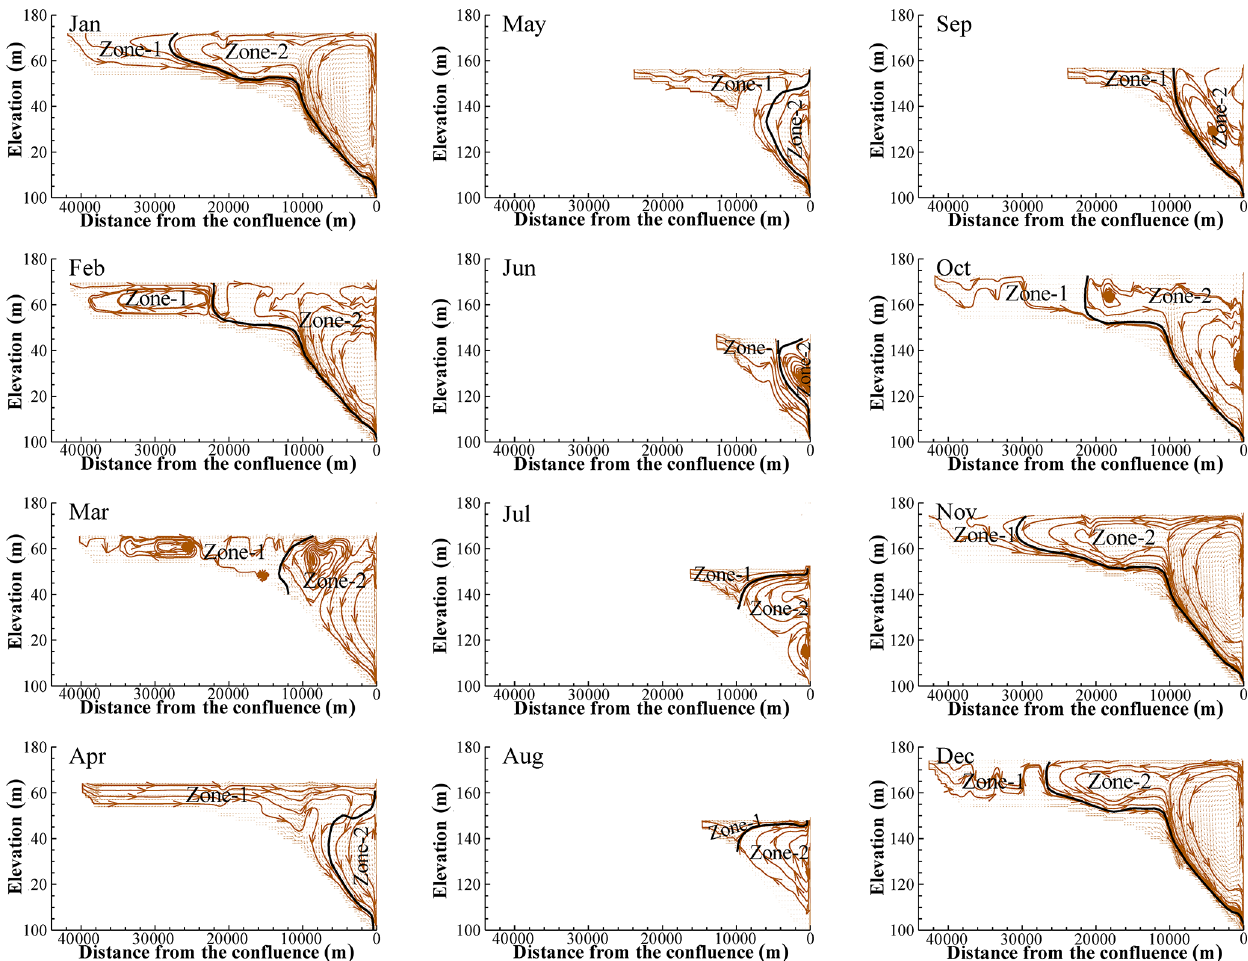
Figure 7. Distribution of the flow field in each month. The flow field was divided into two areas (zone 1 and zone 2) according to the flow field characteristics. The black curve in the figure is the boundary between zone 1 and zone